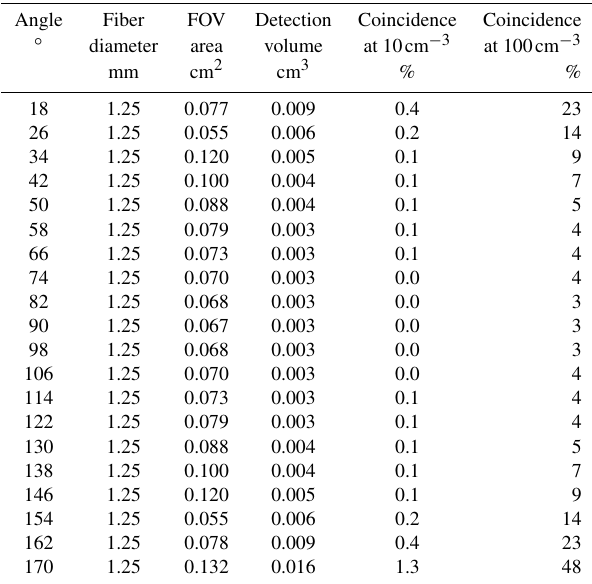
Table 1. Field of view (FOV) areas, detection volumes, and coin- cidence probabilities for the optical arrangement of the polar neph- elometer of PHIPS-HALO. Note that coincidence can be neglected for cirrus but might be considered for mixed-phase cloud condi-